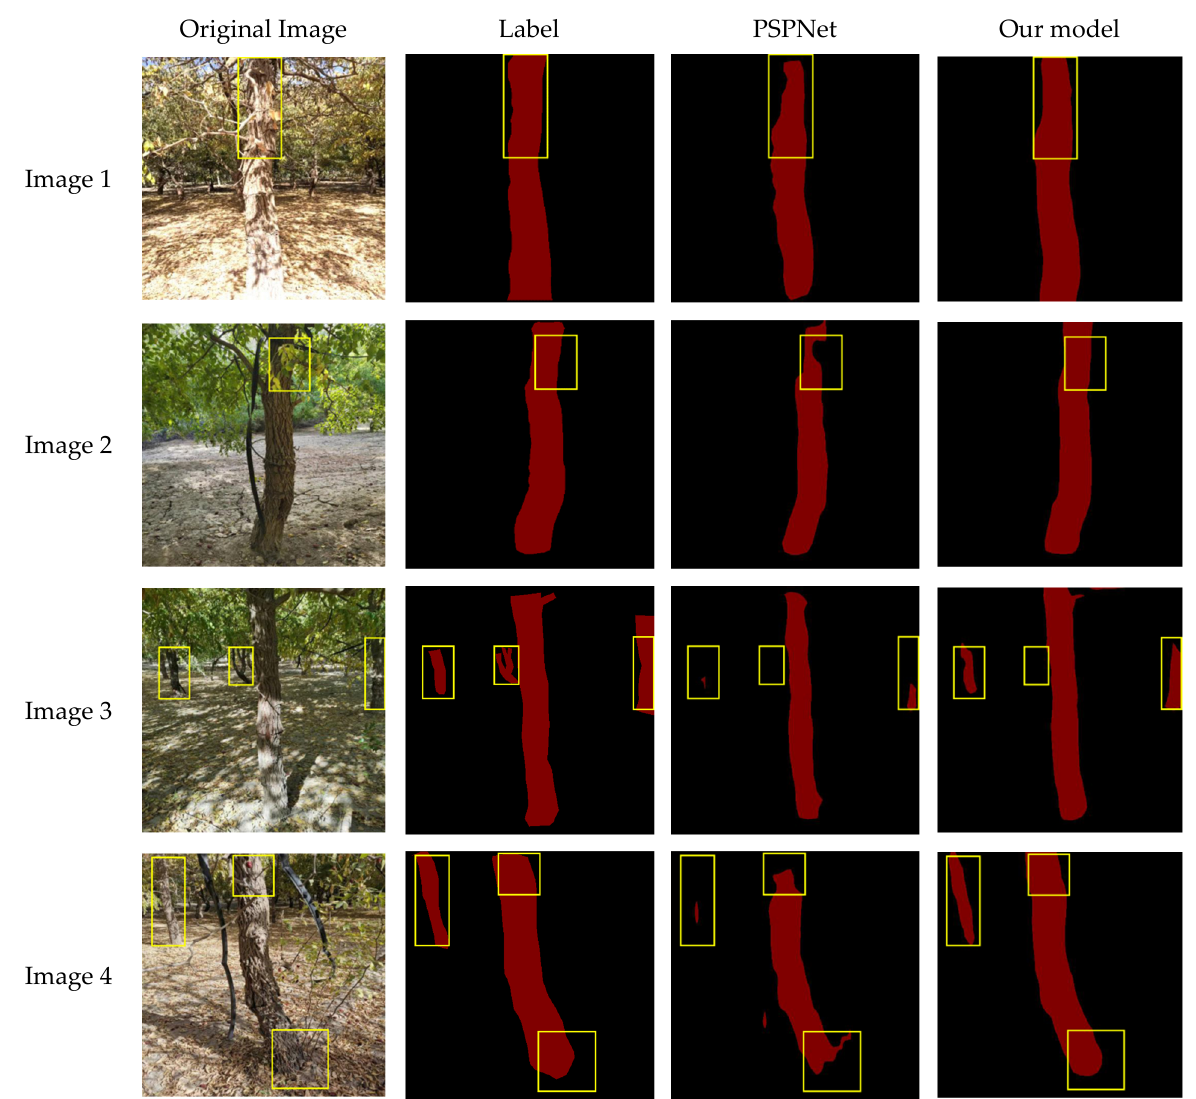
Figure 15. Results of jujube recognition by different algorithms. Image 1 was a single-target jujube tree trunk image with branches. Image 2 was a single-target jujube tree trunk image with leaves and sundries. Image 3 was a multi-target jujube tree trunk image. Image 4 was a multi-target jujube tree trunk image with sundries, in which the yellow box was manually marked.